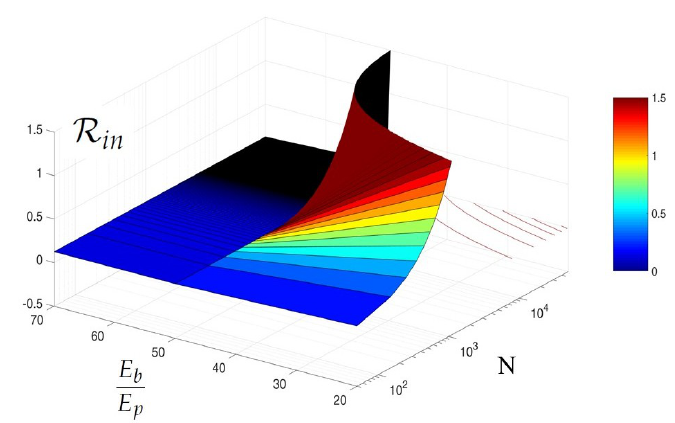
Figure 5. R in versus E b / E p , N , L = 8, ρ CS = 0.25, ρ enc =